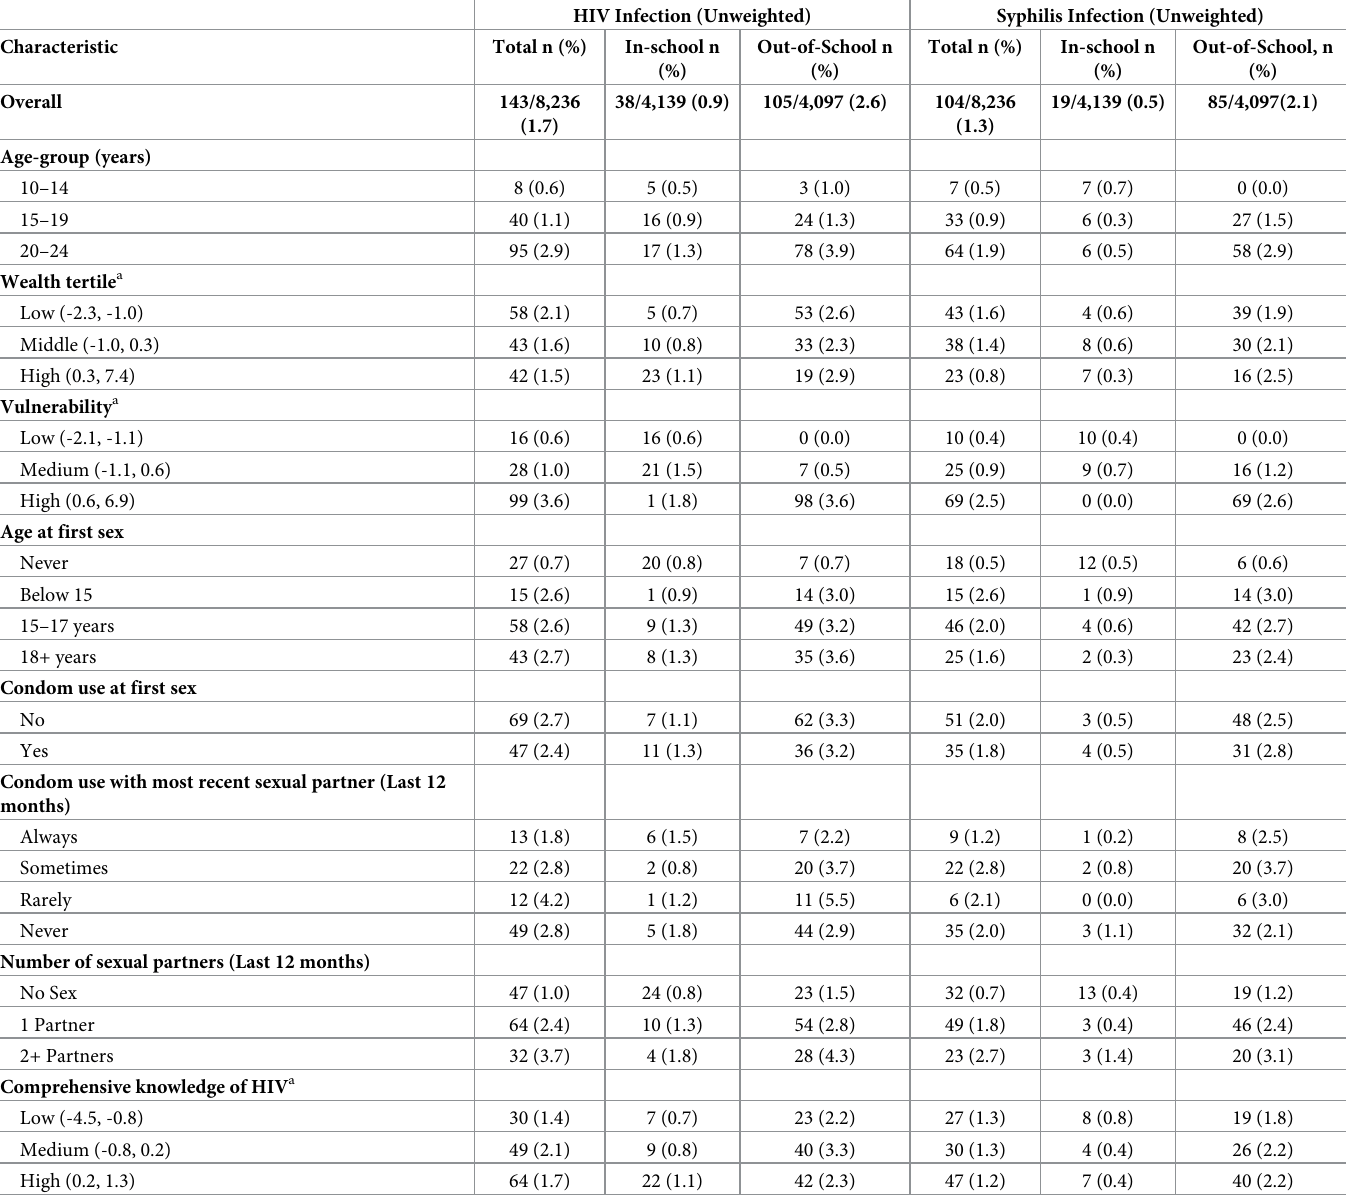
Table 4. Distribution of HIV and syphilis prevalence by schooling status and selected sexual-risk